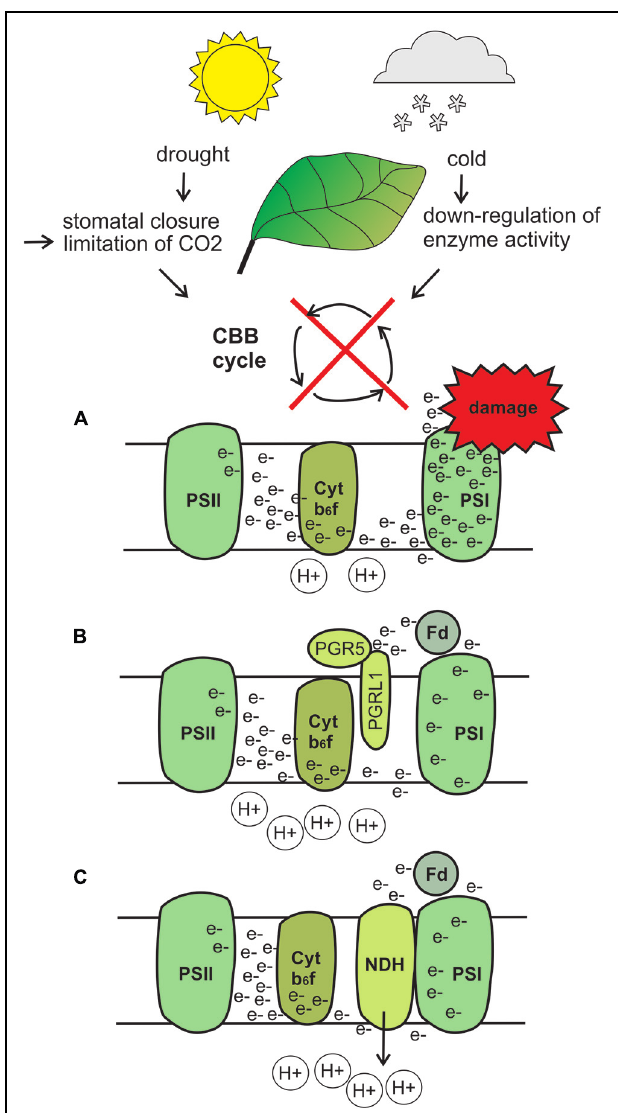
FIGURE 1 | Hypothetical model describing upregulation of cyclic electron flow (CEF) under drought and cold stress. Drought stress induces stomatal closure and subsequent limitation in CO 2 levels, whereas cold stress slows down the enzyme activity. Both conditions result in downregulation of the Calvin-Benson-Bassham cycle. (A) A hypothetical situation in which CEF would not function, and which would thus end up in severe over-reduction of the ETC and stroma, and finally to photodamage. (B) When the PGR5 and PGRL1 proteins receive electrons from ferredoxin (Fd) and trigger lumen acidification, electron flow toward PSI becomes, thus preventing ETC and stromal components from over-reduction and photodamage. In addition, lumen acidification leads to induction of non-photochemical quenching (NPQ; not drawn to the figure). (C) The NDH complex receives electrons from Fd, thus functioning as a safety valve for the excess of electrons. Furthermore, NDH likely functions as a proton pump, which participates in lumen acidification. Note that under most natural conditions, drought and cold likely induce upregulation of both CEF routes to some degree, but the preferential route depends on plant species. The illustrations describe only the hypothetical, not the actual position of the proteins and protein complexes. CBB, Calvin-Benson-Bassham cycle; PSI, photosystem; Fd, ferredoxin; e − , electron; H + ,